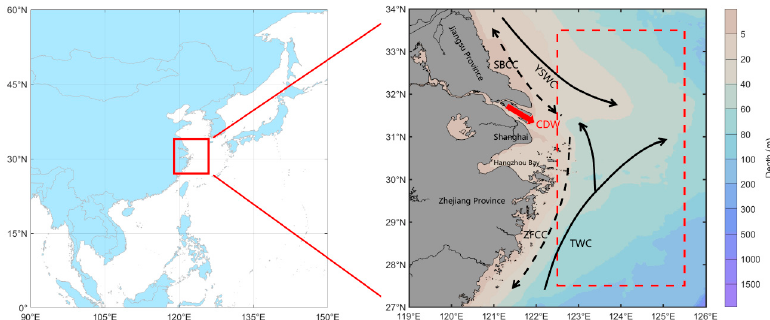
Figure 1. Bathymetry and regional ocean circulations in the study area. The arrows indicate the Changjiang Diluted Water (CDW), Yellow Sea Warm Current (YSWC), SuBei Coastal Current (SBCC), Zhejiang–Fujian Coastal Current (ZFCC), and Taiwan Warm Current (TWC) [20,21]. The red dashed box is Zone A (122.5–125.5 ◦ E, 27.5–33.5 ◦ N), where the regional average was calculated for comparison with WOA13 data (detailed in Section